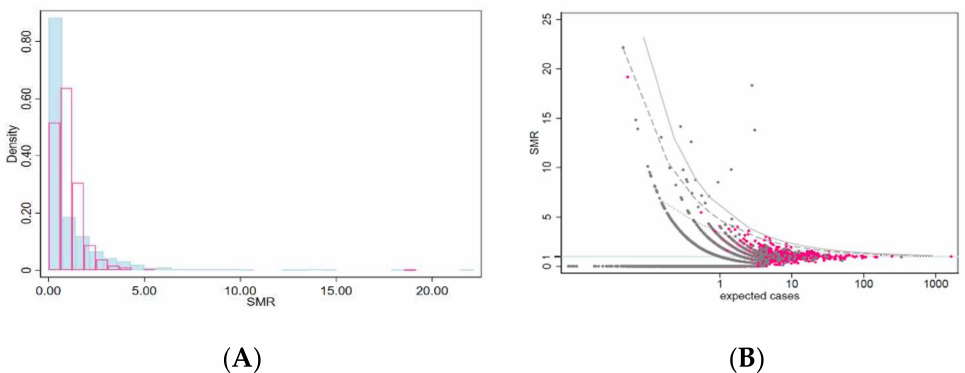
Figure 1. ( A ) Histogram of standardized mortality ratios (SMR) by municipality (pleural cancer (light-blue) and ovarian cancer (pink)). Lombardy Region, 2000–2018. ( B ) Funnel plot of SMR for pleural cancer (grey) and ovarian cancer (pink) by municipality vs. expected number of cases (log scale). One-sided confidence bands 0.99 (dotted line); 0.999 (dashed line); 0.9999 (solid